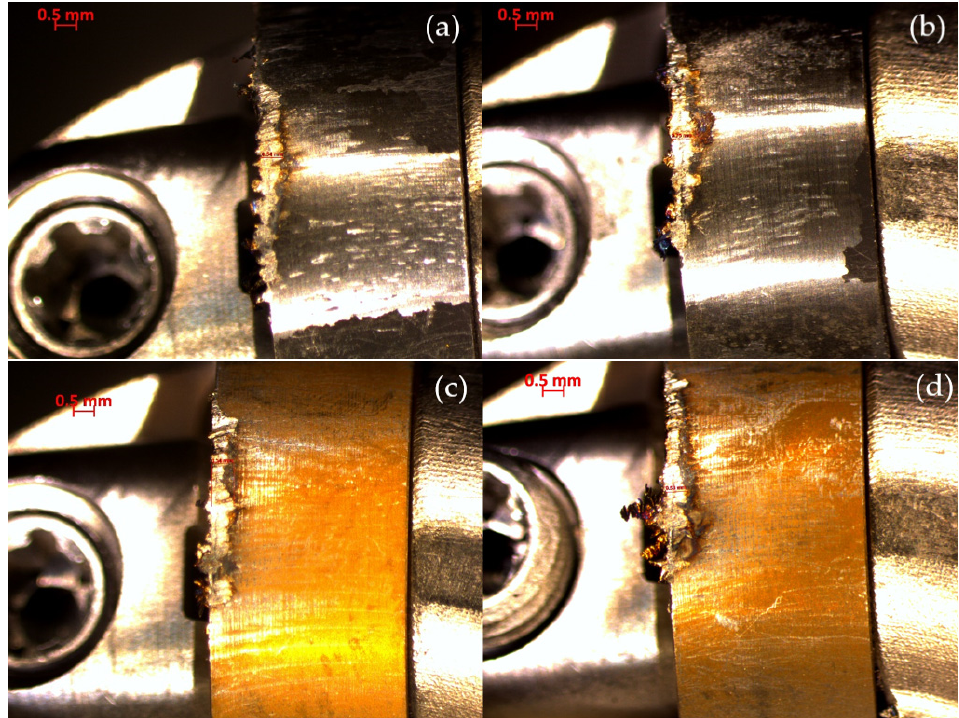
Figure 24. Coating A RNGN insert test at ( a ) 700 m/min and ( b ) 800 m/min. Coating B RNGN insert test at ( c ) 700 m/min ( d ) 800 m/min.